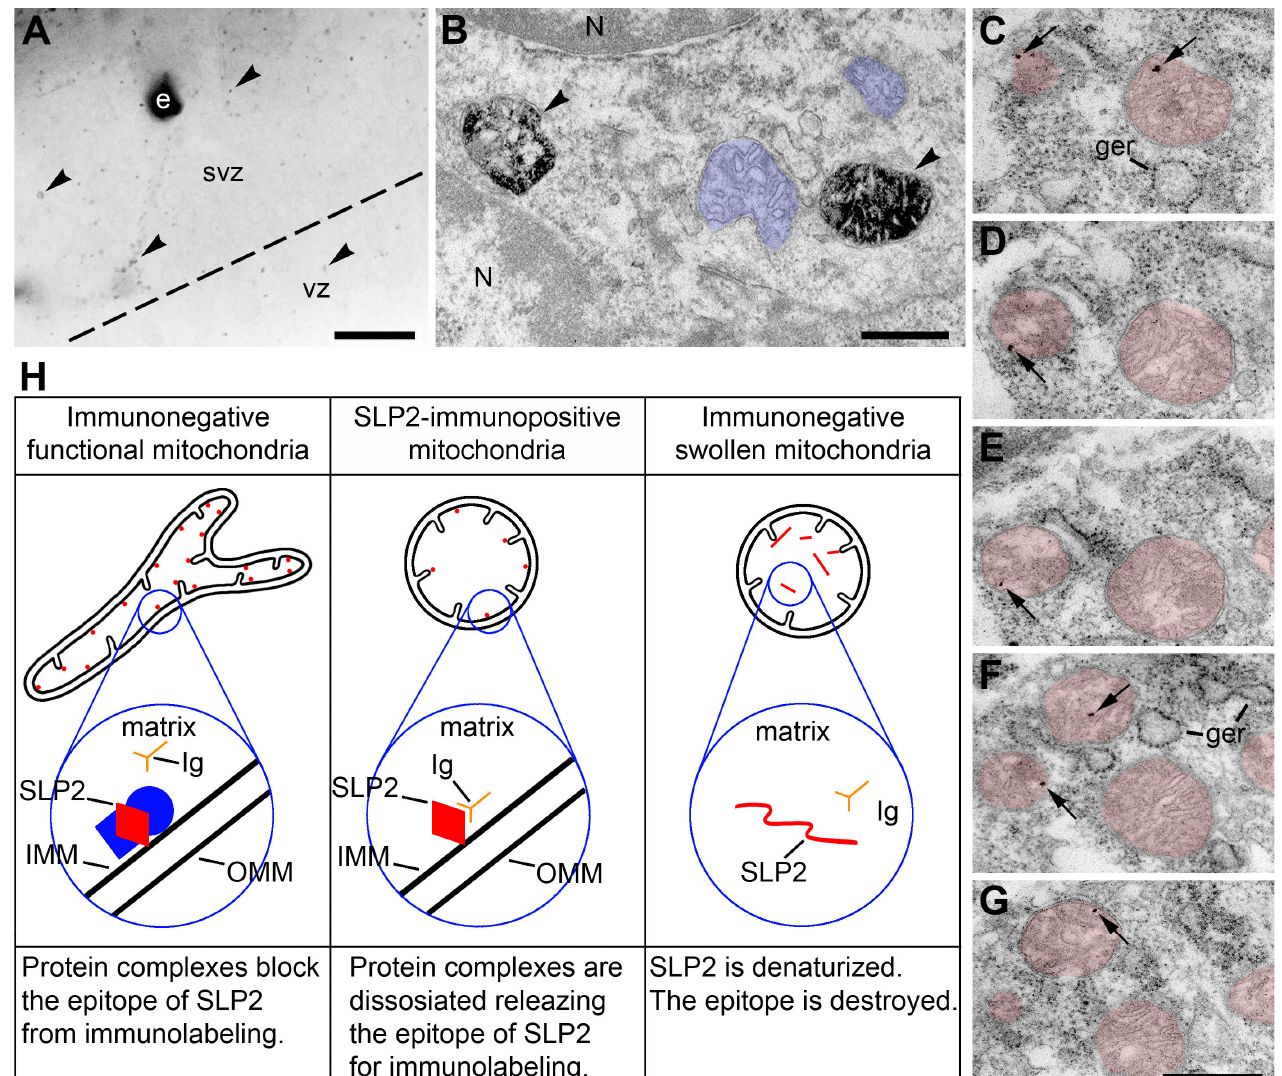
Figure 5. ( A – G ) Immunolabeling of disordered mitochondria in the cerebral cortex ventricular zone (vz) and subventricular zone (svz) of E13 mouse embryos after 4.5 h anoxia using CB 1 R-L31 antibodies. ( A , B ) Light and electron micrographs of the neuropil labeled with immunoperoxidase-DAB-Ni. Immunopositive mitochondria are pointed to with arrowheads. Notice that black immunoreaction end-product in ( B ) accumulates in the matrix, while the cristae stay immunonegative. Some mitochondria, although swollen, remain immunonegative (highlighted blue). ( C –G) Serial electron micrographs of mitochondria (highlighted red) immunolabeled with nano-gold and silver amplification. Numerous silver particles (arrows) are located in the mitochondrial matrix and contact the inner membrane in accord with the modern view to location of SLP2 on the inner surface of inner mitochondrial membrane [39]. Scale bars, 20 μ m in ( A ); 500 nm in ( B–G ). ( H ) Hypothetical schema of the relationships between mitochondrial morphology, molecular conformation of the SLP2 protein, and CB 1 R-L31 antibodies (Ig). Proteins that make a complex with SLP2 on the inner surface of inner mitochondrial membrane (IMM) are depicted blue. Abbreviations: e, erythrocyte; ger, granular endoplasmic reticulum; N, cell nucleus; OMM, outer mitochondrial membrane.